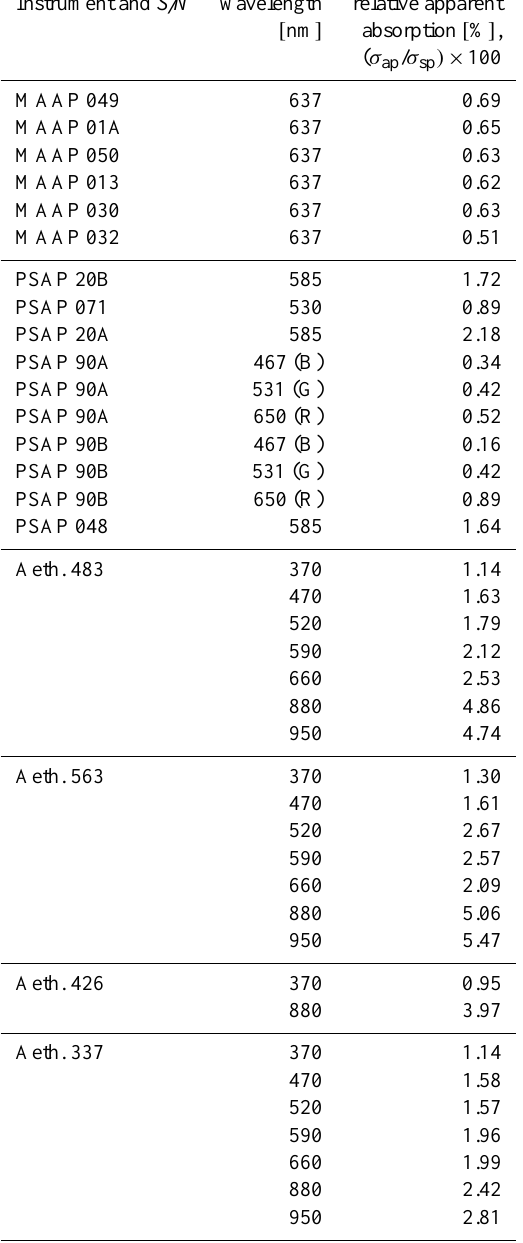
Table 11. Response to ammonium sulfate at GAW2005. PSAP and Aethalometer data were corrected following Bond et al. (1999) and Weingartner (2003), respectively, to show the remaining cross sensitivity to particle scattering.